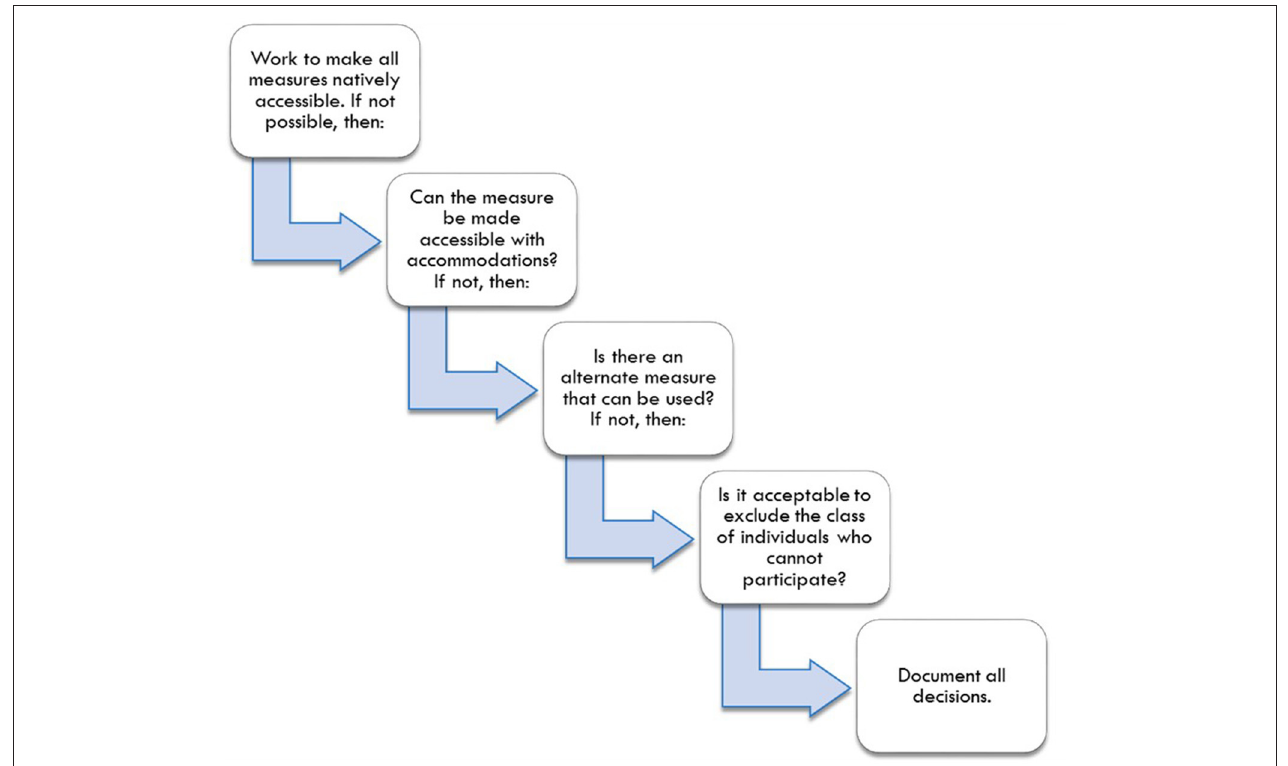
FIGURE 2 | Decision process for creating accessible health